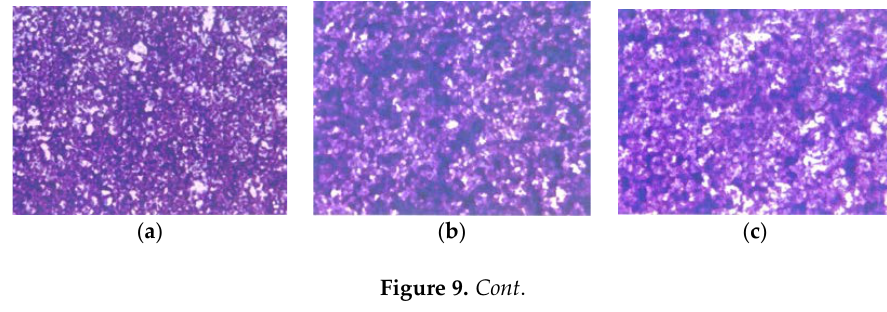
Figure 8. Effect of EPQ on Matrigel invasion of A-2780 cells: photomicrographs ( a ) Control, ( b ) EPQ 50 μg/mL, ( c ) EPQ 100 μg/mL, ( d ) EPQ 250 μg/mL.